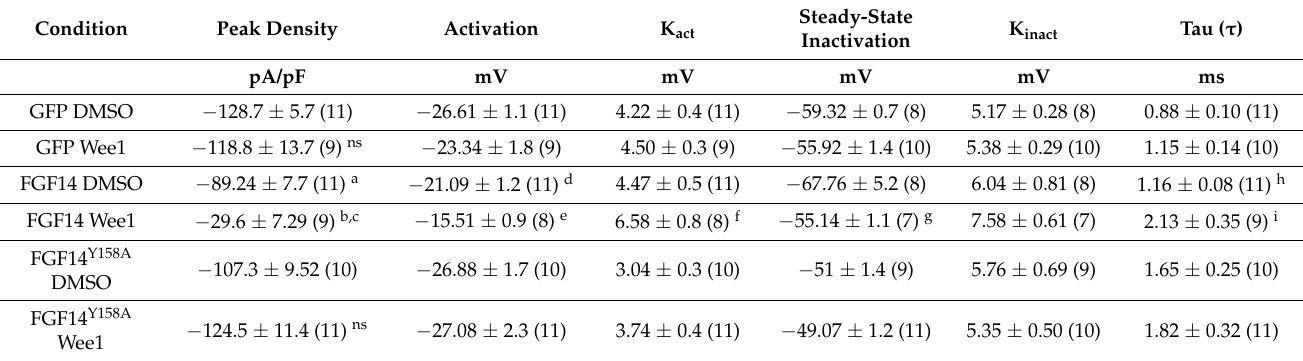
Table 1. Effects of pharmacological inhibition of Wee1 kinase on Na v 1.2-mediated currents † . Condition Peak Density